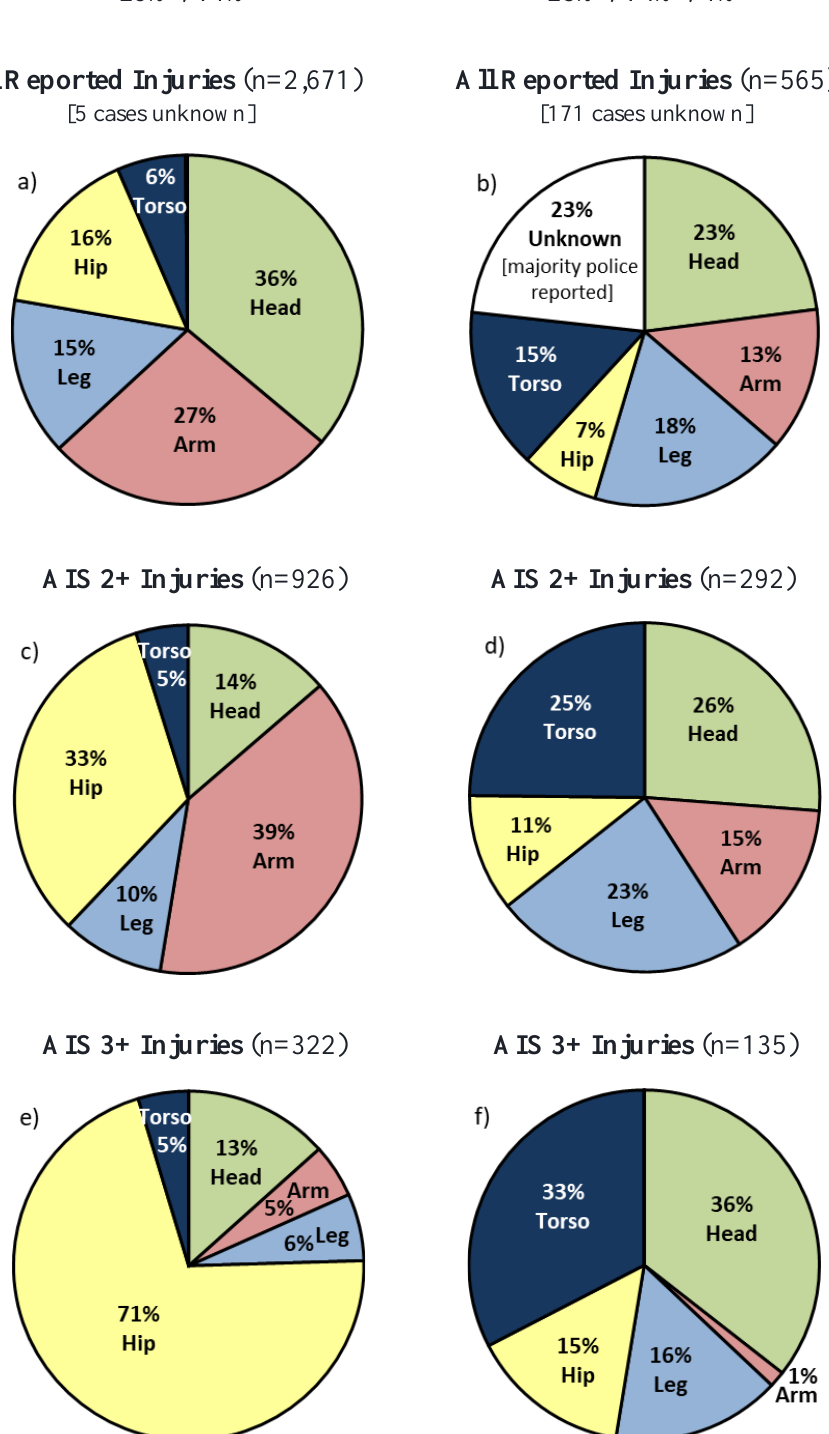
Figure 5. Injured body parts based on: all injuries in a) single and b) collision accidents; AIS 2+ injuries in c) single and d) collision accidents; AIS 3+ injuries in e) single and f) collision